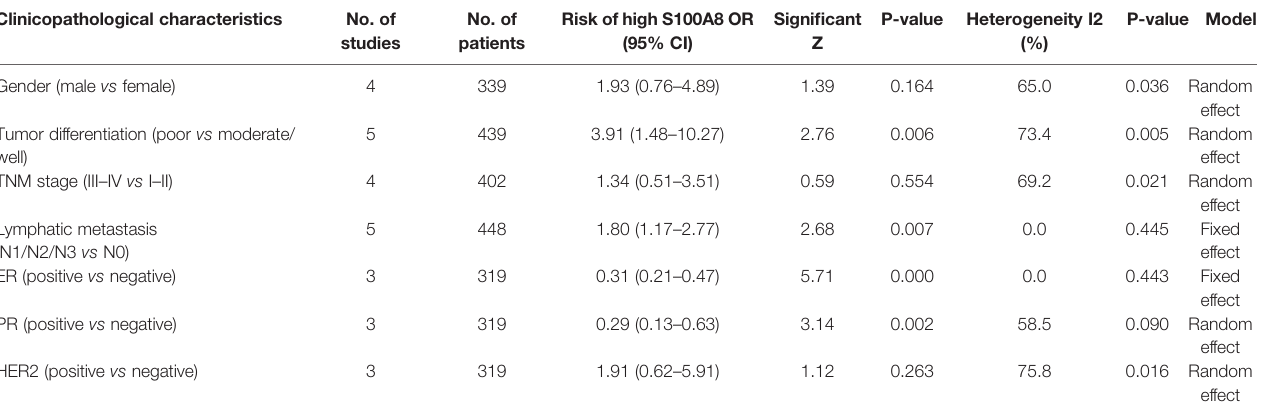
TABLE 3 | Associations between S100A8 expression and clinical pathological characteristics Sensitivity analysis. Clinicopathological characteristics